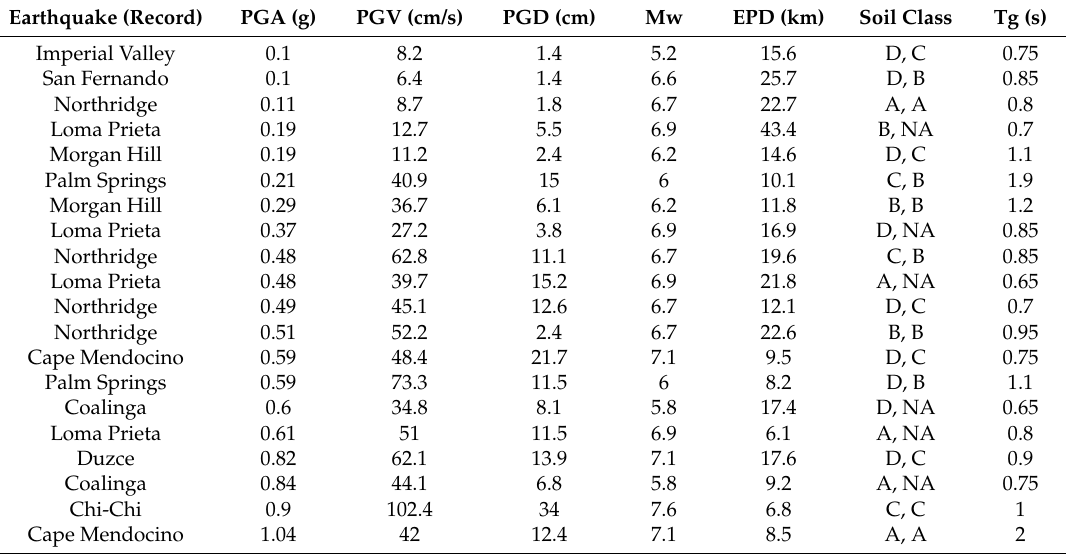
Table 2. Strong ground motion records used as the input to adjacent